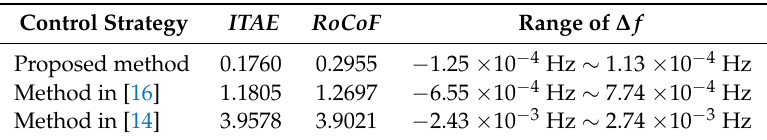
Table 6. Performances with stochastic disturbance of